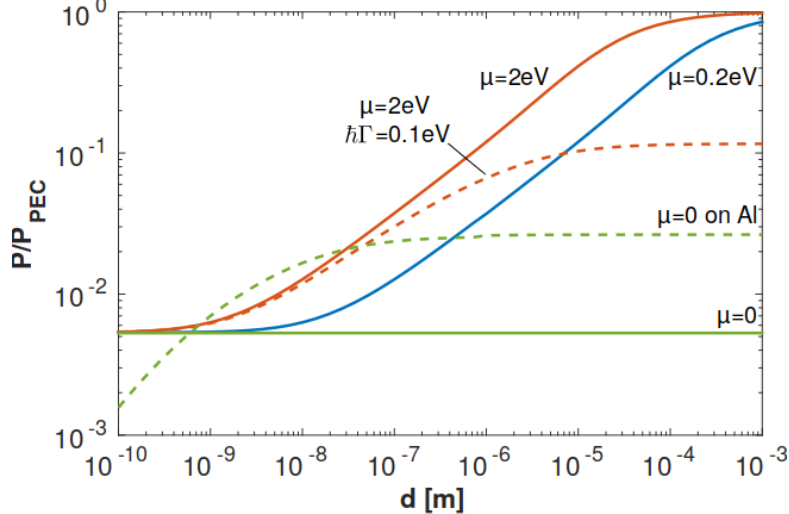
Figure 2. Attractive Casimir pressure between two graphene sheets in a function of distance and normalised to the pressure between two perfect conductors P PEC = − ¯ h c π 2 /240 d 4 . The green line at P / P PEC ∼ 0.00538 is the force between two intrinsic graphene sheets with universal conductance σ 0 = e 2 /4¯ h . Dashed green is one undoped sheet on top of an aluminium (Drude, ¯ h ω p = 12.5eV, ¯ h Γ = 0.063eV) half-space. Full blue (red) is the force between two doped sheets with µ = 0.2eV ( µ = 2eV) and zero relaxation frequency. Dashed red is the same as red but with Drude damping included (¯ h Γ =